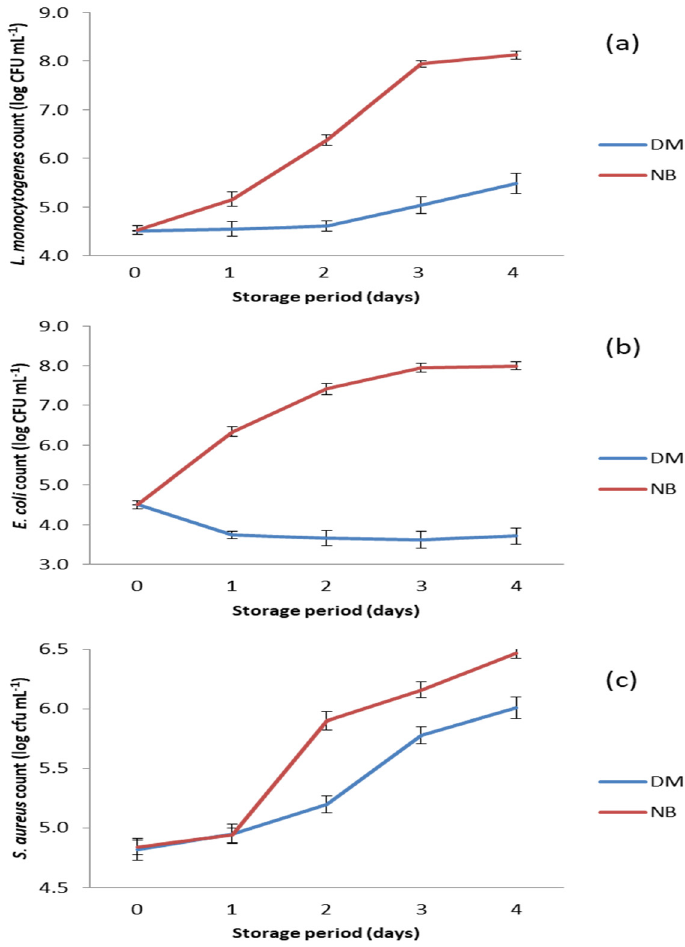
Figure 3. Counts of bacteria tested in the DM and the nutrient broth (NB) during storage at 15 °C. ( a ) S. aureus count; ( b ) E. coli count; and ( c ) L. monocytogenens count.